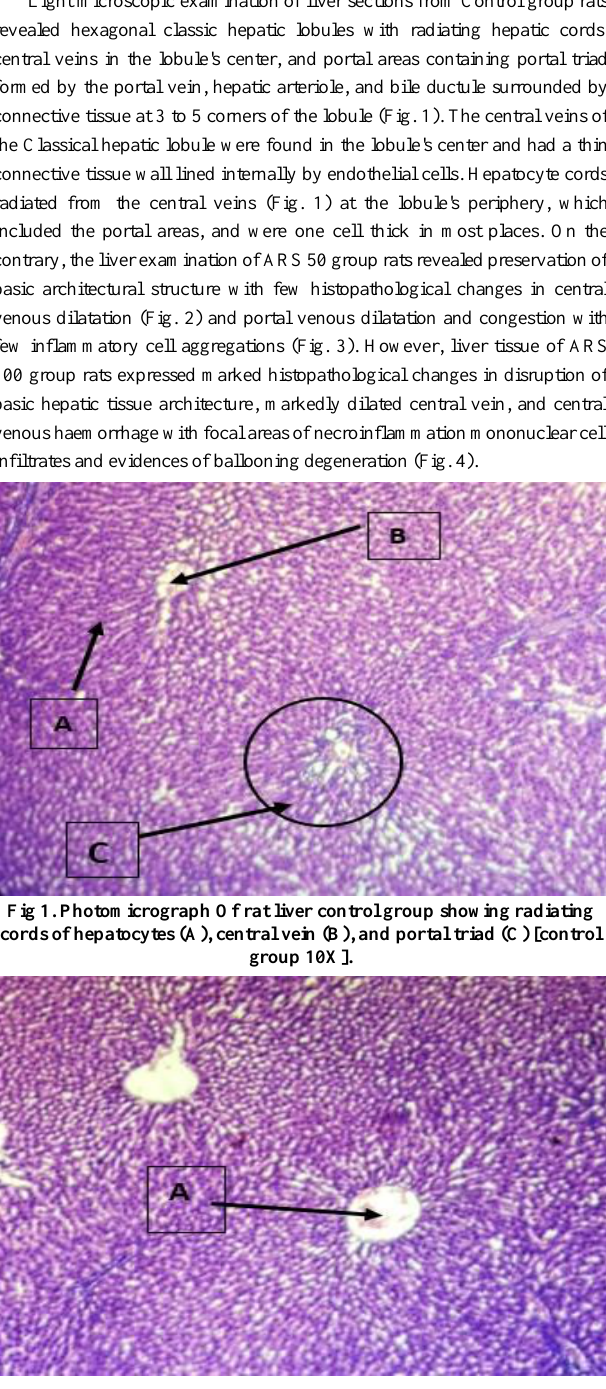
Fig. 2. Photomicrograph Of rat liver showing dilated central vein (A) [ARS 50